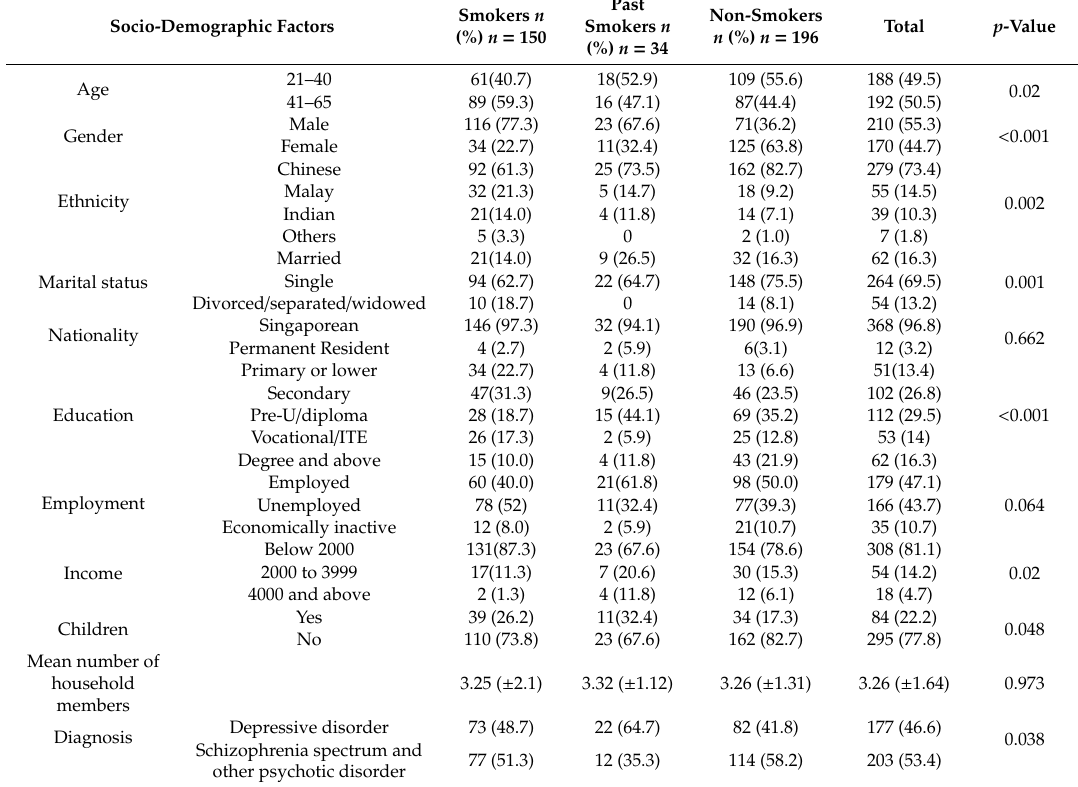
Table 1. Socio-demographic characteristics of the